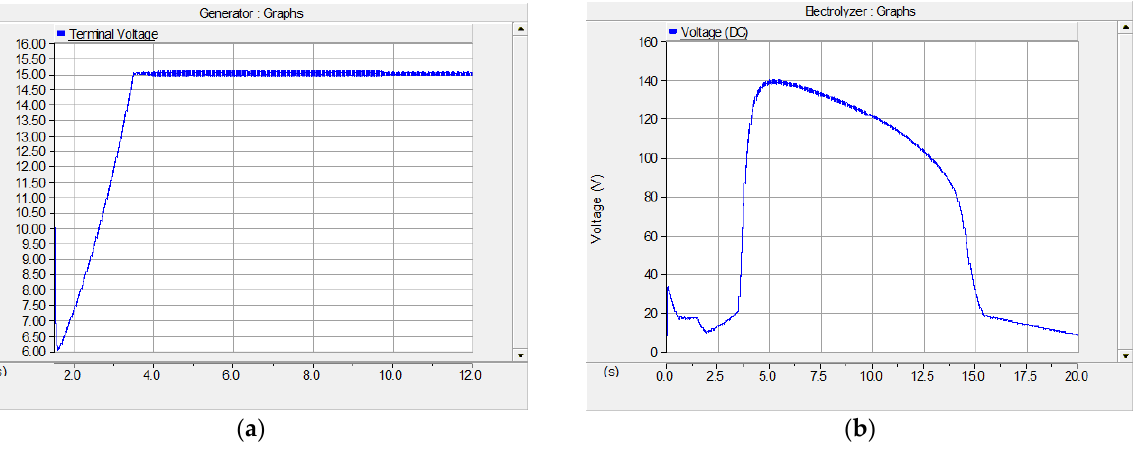
Figure 28. ( a ) Terminal voltage; ( b ) DC voltage.